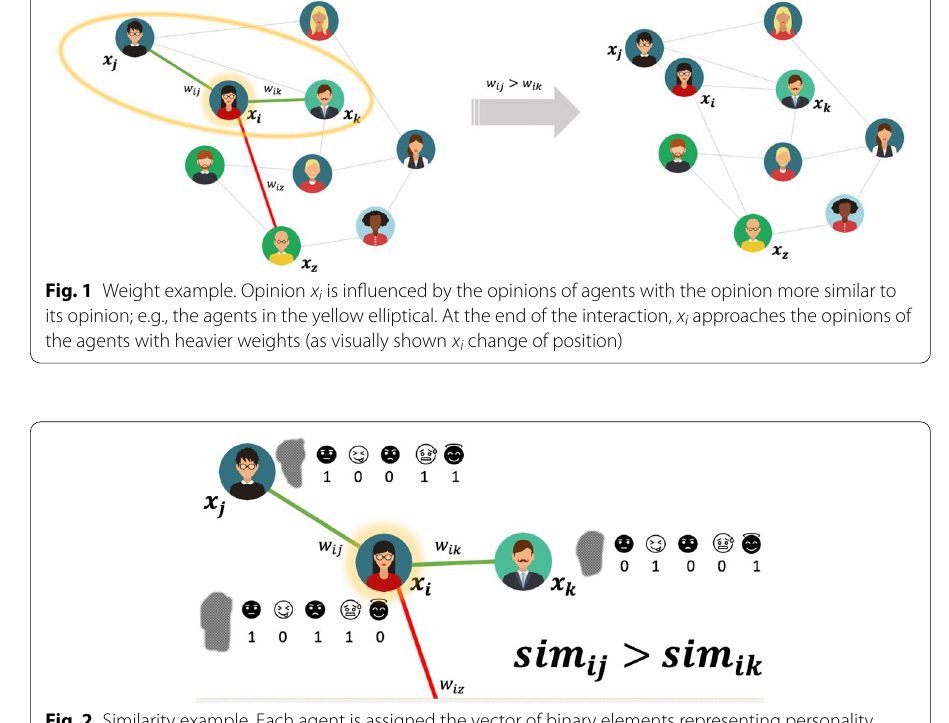
Fig. 2 Similarity example. Each agent is assigned the vector of binary elements representing personality